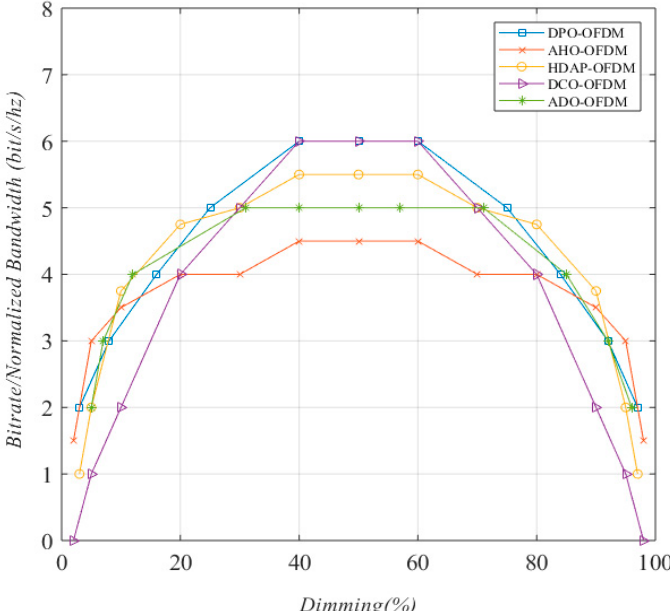
Figure 9. Dimming Range of dc-biased pulse amplitude modulated OFDM (DPO-OFDM) and other OFDM forms where OFDM stands for orthogonal frequency division multiplexing. Next, we show the dimming control of a hybrid OFDM scheme by switching its individual components. For instance, HDAP is considered in evaluating the effectiveness of switching components. Using the concept of AAD-OFDM reported in [24], we can obtain greater spectral efficiency, as well as a wide dimming range with dimming control for the components of HDAP. In HDAP, DCO is placed in lower half subcarriers. In the upper half, odd and even imaginary parts ACO and PAM-DMT are placed,